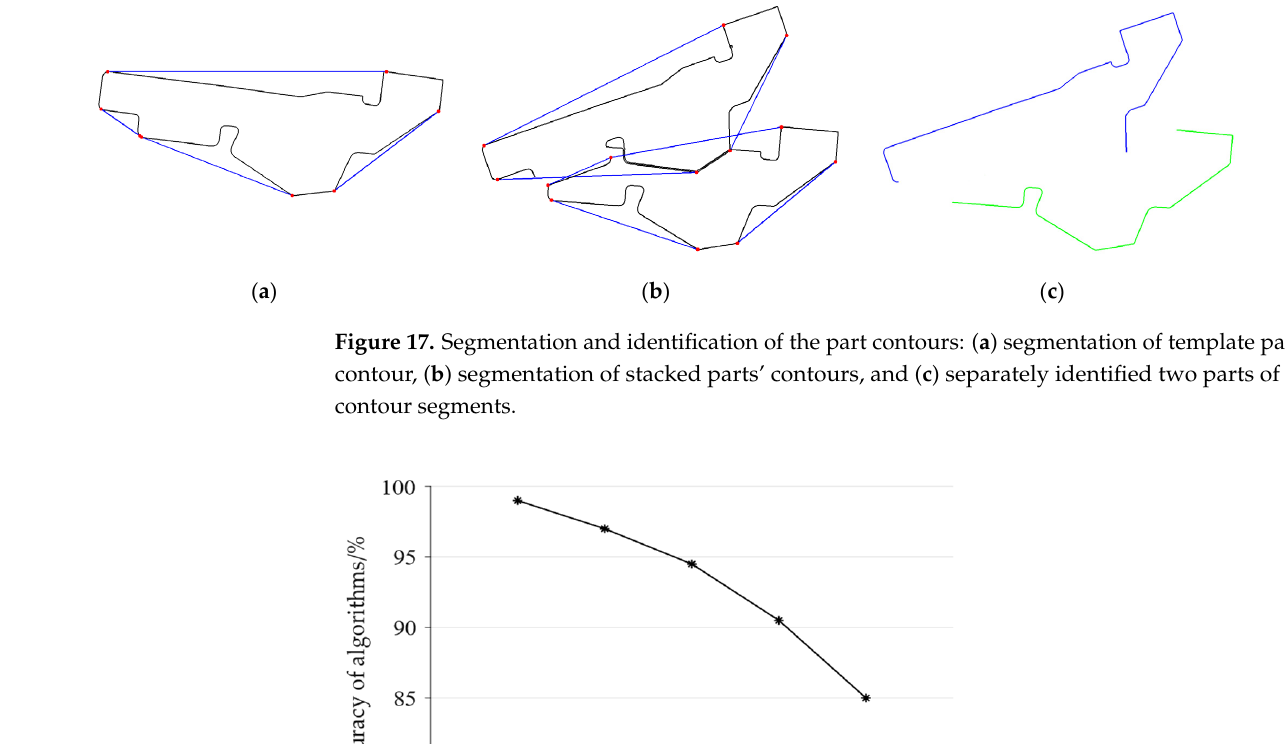
Figure 16. Image of parts’ edges detected by the Canny algorithm: ( a ) stacked sheet metal parts; ( b ) contours of the part.